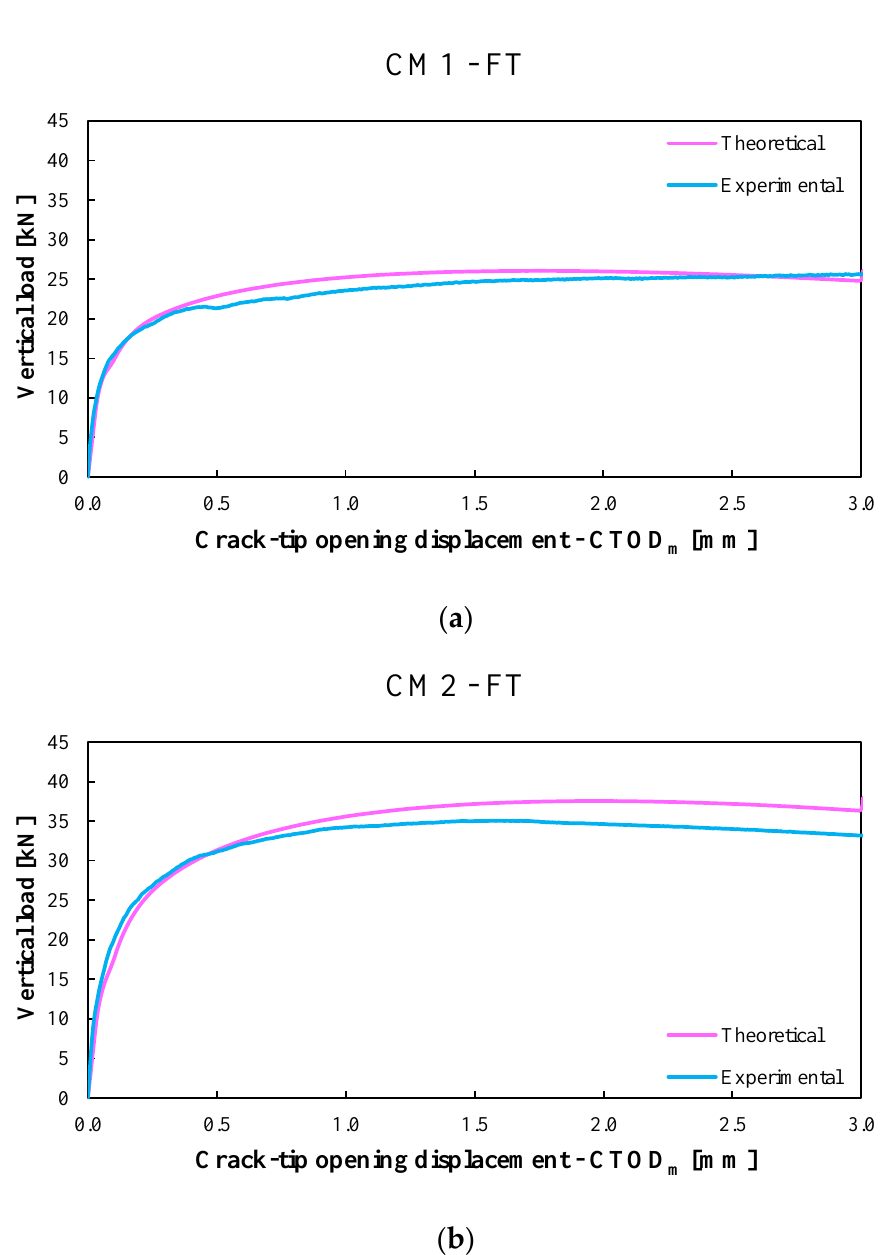
Figure 10. ( a ). The average experimental P − CTOD , avg curve (light-blue line) versus the average numerical P − CTOD , avg curve (pink line) for conditioned CM1 specimens (labelled CM1-FT) obtained with the present model. ( b ). The average experimental P − CTOD , avg curve (light-blue line) versus the average numerical P − CTOD , avg curve (pink line) for conditioned CM2 specimens (labelled CM2-FT) obtained with the present model.